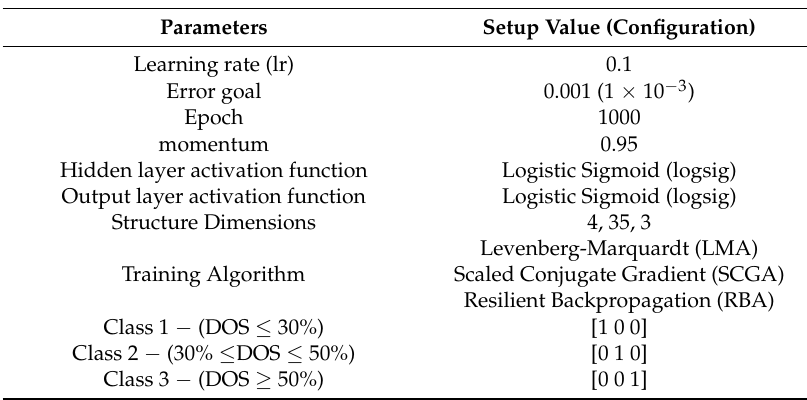
Table 4. Parameter setup.